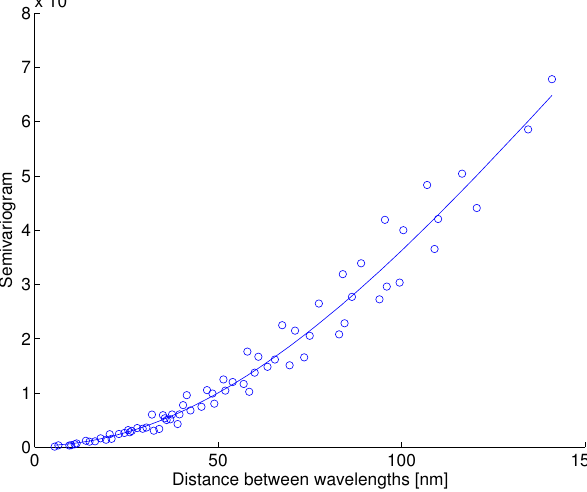
Fig. 3. The variance of the residual differences versus wavelength distance is expressed by the empirical semivariogram (circles) and the fitted Gaussian parametric semivariogram model (solid